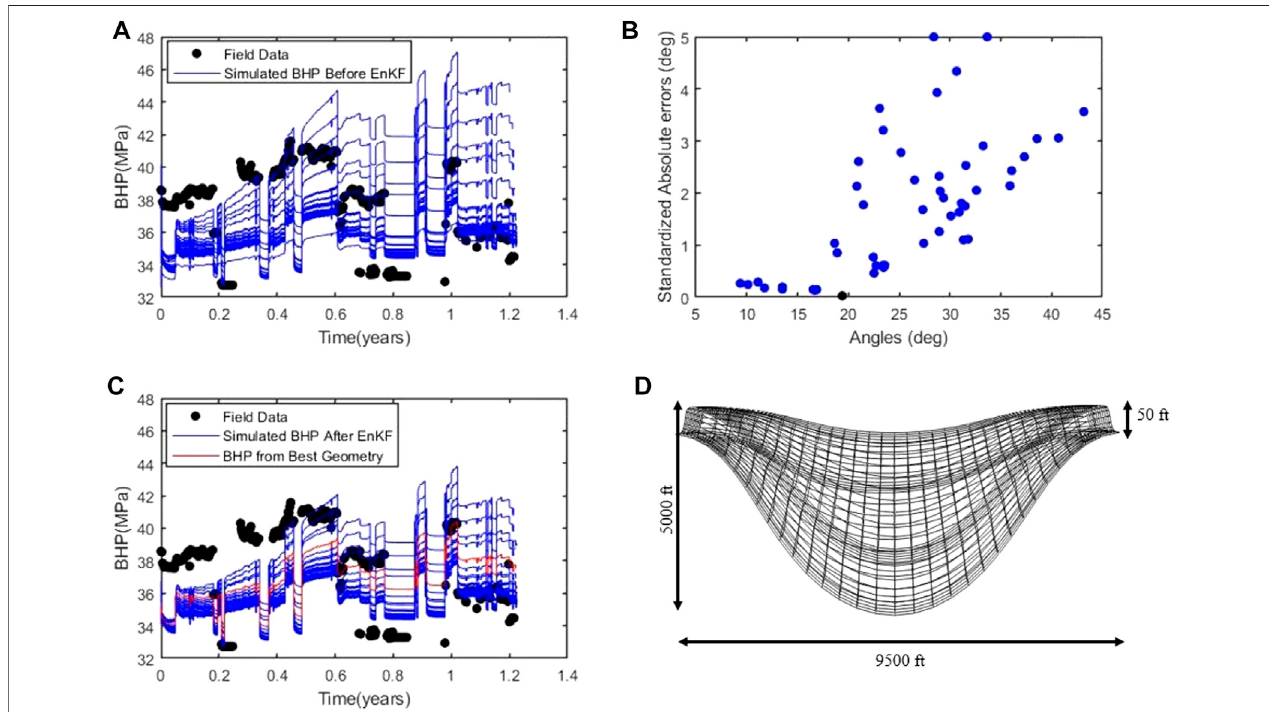
FIGURE 11 | Results obtained by applying the EnFK procedure at the end of the simulation period, (A) BHP before EnFK. (B) the updates to the angular displacement obtained using EnFK for various members of the initial ensemble (C) BHP after EnFK. Red plot indicates BHP from geometry with least error (D) Updated point bar geometry with the least error to be used in the next phase of work fl